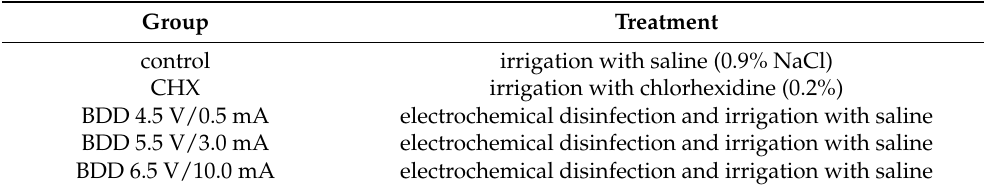
Table 1. Protocol for multispecies biofilm removal of infected root canals. Experimental groups (n = 3 roots per group) and final disinfection steps rendered following root canal